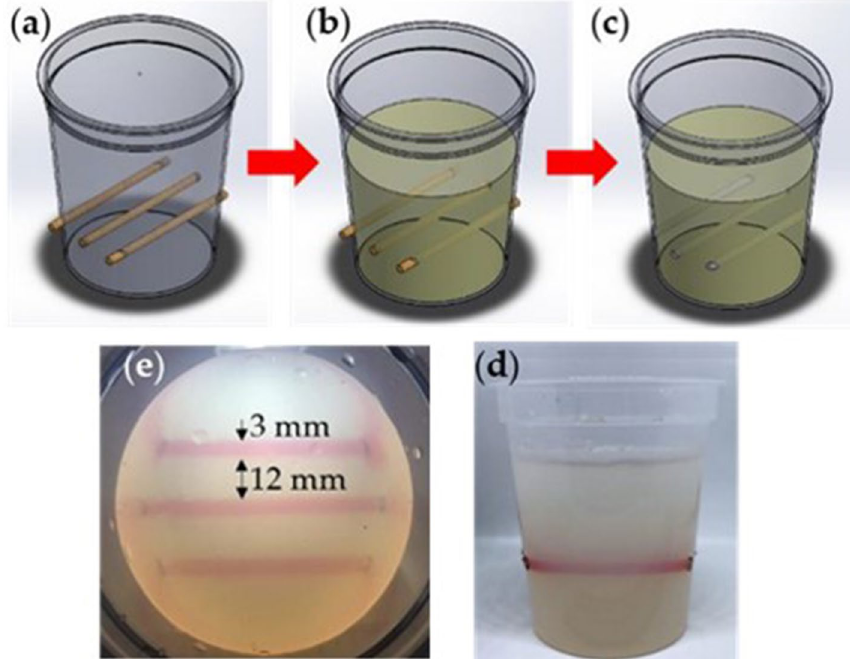
Figure 1. Fabrication of gel medium with embedded channels. ( a ) container with removable cores, ( b ) casting of gel and ( c ) removable of cores to form channels subsequently filled with aqueous nutrient solution. ( d ) and ( e ) are side and top views, respectively, of channels filled with aqueous red dye solution for contrast. (Image was created using Solidworks, Version 2017 SP, https ://www.solid works .com, and MS-Powerpoint, Version 16.16.22 (200,509) (Microsoft PowerPoint for Mac), https ://www.micro soft.com).